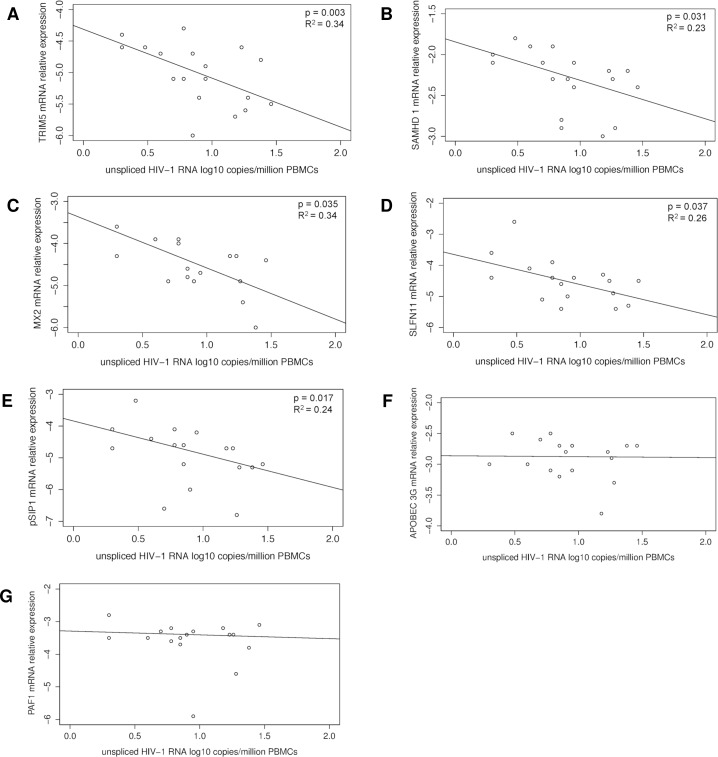
Linear regression analysis between unspliced (us) HIV-1 RNA and restriction factors.Associations between us HIV-1 RNA and: A) TRIM5α; B) SAMHD1; C) MX2; D) SLFN11; E) pSIP1; F) APOBEG3G; and G) PAF1.